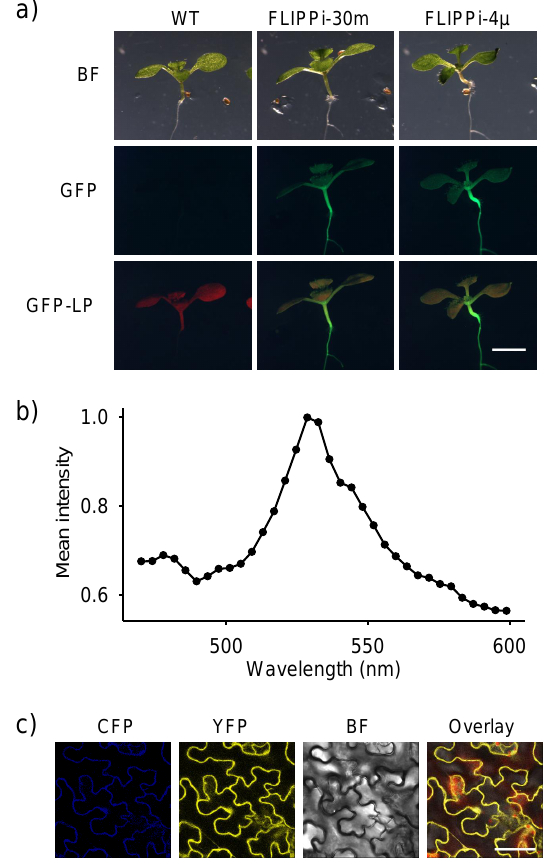
Figure 2. Expression of FLIPPi-30m and FLIPPi-4 µ sensors in wild-type Arabidopsis. ( a ) Images from fluorescent microscopy of 12-day-old seedlings of Arabidopsis wild-type (WT), FLIPPi-30m and FLIPPi-4 µ lines, observed with bright field (BF) and GFP filters (GFP, GFP-longpass). Scale bar: 2 mm ( b ) Emission spectrum (lambda-scan, λ ) of leaf cells from 12-day-old seedlings of Arabidopsis FLIPPi-4 µ line showing the CFP and YFP emission peaks, corresponding to a wavelength of approximately 470 and 520 nm, respectively. ( c ) Image from the CSLM-lambda ( λ ) scan in (b) showing the CFP, YFP, bright field (BP) and overlay channels. The same emission spectra (lambda-scan, λ ) were obtained with seedlings of all independently transformed T3 generation Arabidopsis FLIPPi-4 µ and FLIPPi-30m lines. Scale bar: 40 µ